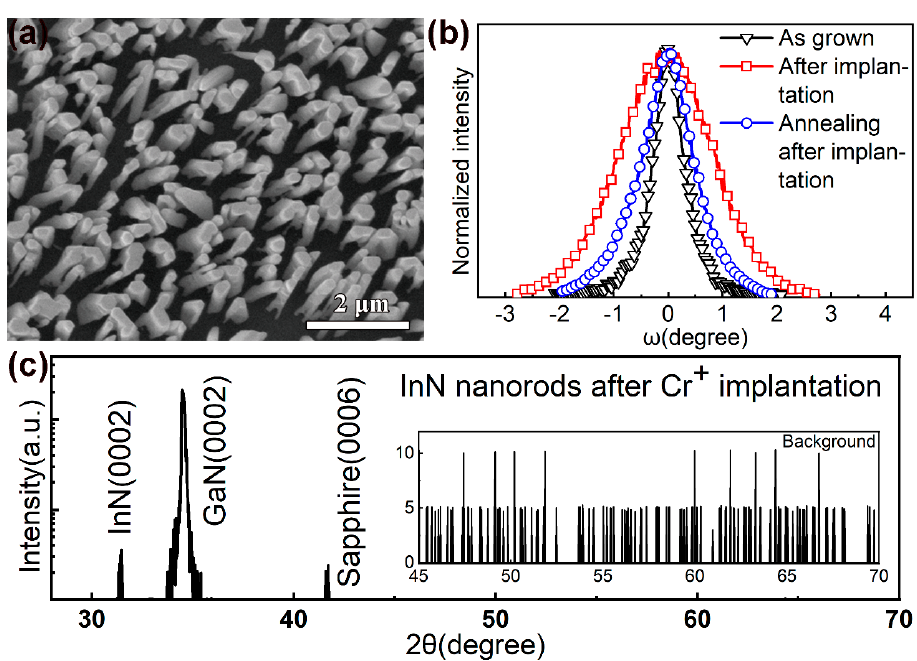
Figure 1. ( a ) Field-emission scanning electron microscope (FESEM) image of the InN nanorods on GaN (0002) substrates; ( b ) (0002) rocking curves of the InN nanorods; ( c ) XRD θ –2 θ scans of the InN nanorods.